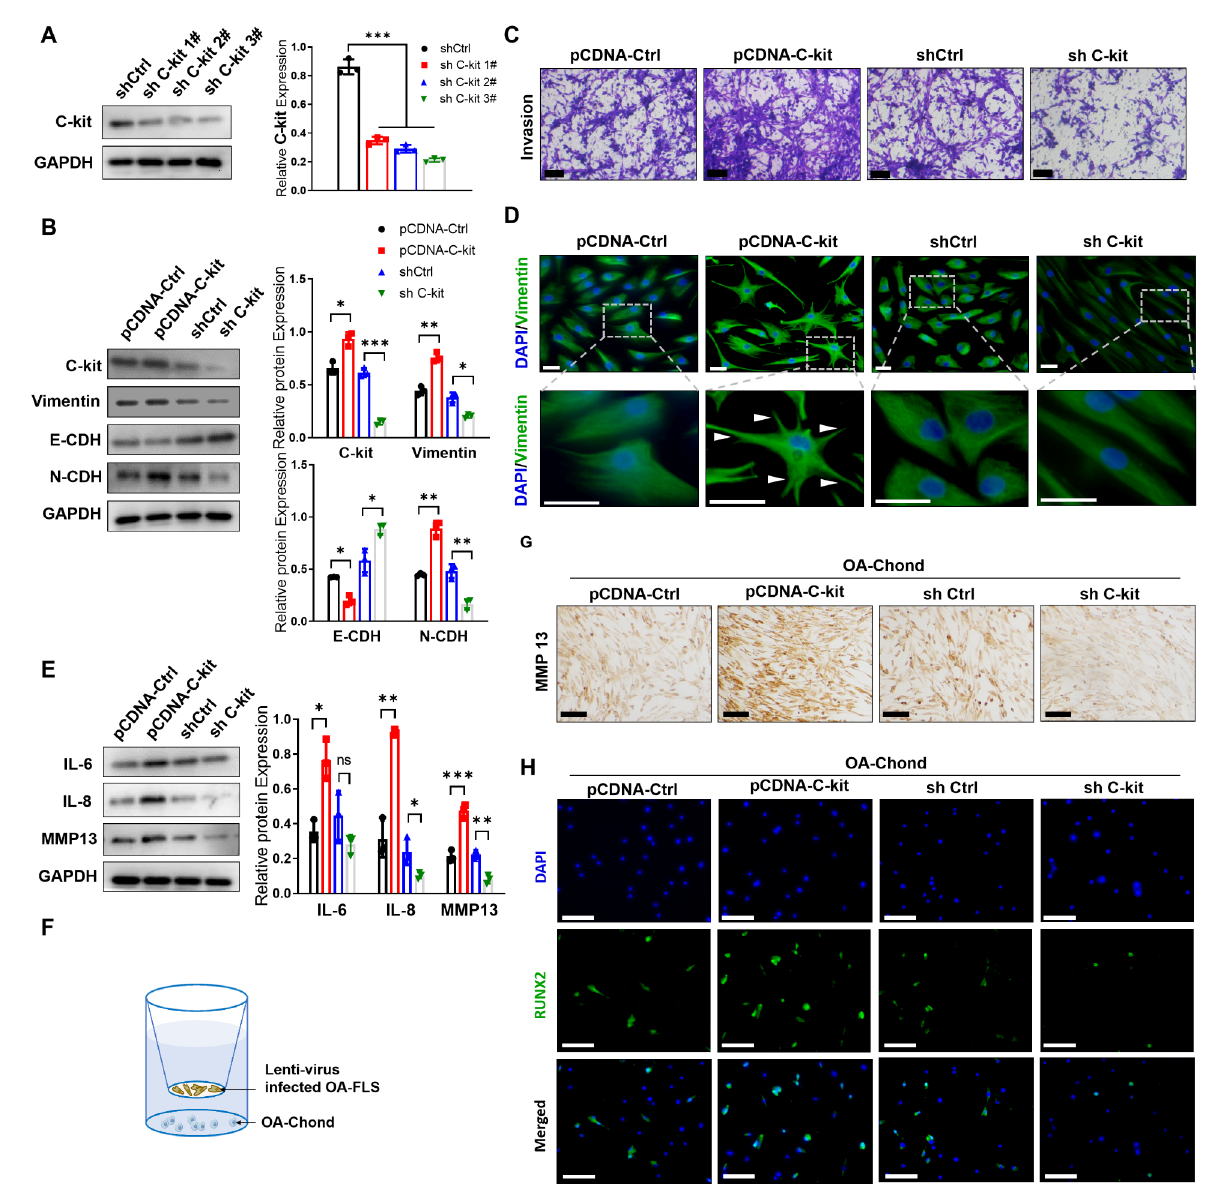
Fig. 5 C-kit inhibition protects rats from mechanical instability induced OA model (A) Tracing of lenti-virus packaged EGFP-shC-kit (green) with intra-articular injection. (B) Expression of C-kit in synovium and cartilage derived from con- trol, Hulth, and Hulth + shC-kit rats. (C) HE staining (above, bar = 500 μm) and amplified C-kit staining (below, bar = 100 μm) focused on synovium and car- tilage (F: femur; T: tibia; M: meniscus; S: synovium) (n = 3). (D-E) EMT-related genes’ (D, E) and inflammatory factors’ (D) expression in rats synovium (n = 3). (F) Safranin O/fast green staining of cartilage (up) and OARSI semi-quantitative scoring system. including cartilage, subchondral bone, osteophyte and synovitis (bottom) (n = 3, bar = 800 μm). (G) The medial joint space (white arrow, between two dotted lines) in coronal position of total knee and MOAKS score by magnetic resonance imaging (n = 3, bar = 1000 μm). ∗ p < 0.05; ∗∗ p < 0.01; ∗∗∗ p < 0.001. MFC: medial femoral condyle; MTP: medial tibial